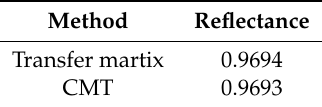
Table 1. Coefficients of reflection at the frequency of the